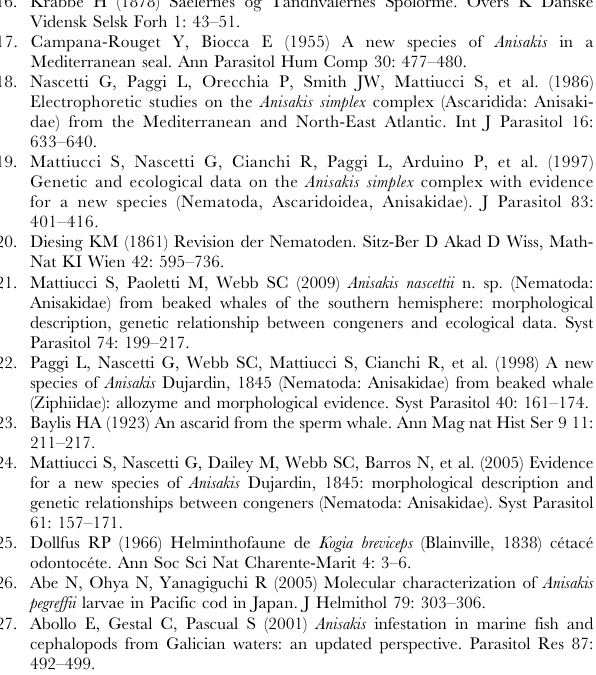
Figure S1 Sampling locations of anisakid nematodes for molecular species identification. Locations marked with red dots and respective locality abbreviations. Asterisks indicate multiple sampling sites. Abbreviations are listed in Table S1.